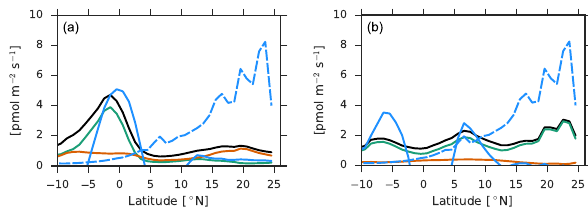
Figure D1. Zonal means in the Indian Ocean for RETRO (a) and CNTRL (b) of iron demand for net primary production (all phyto- plankton: black, bulk phytoplankton: green, cyanobacteria: red), ae- olian iron input (dashed blue), and iron flux due to upwelling (solid blue). All fluxes are given in pmolFem − 2 s − 1